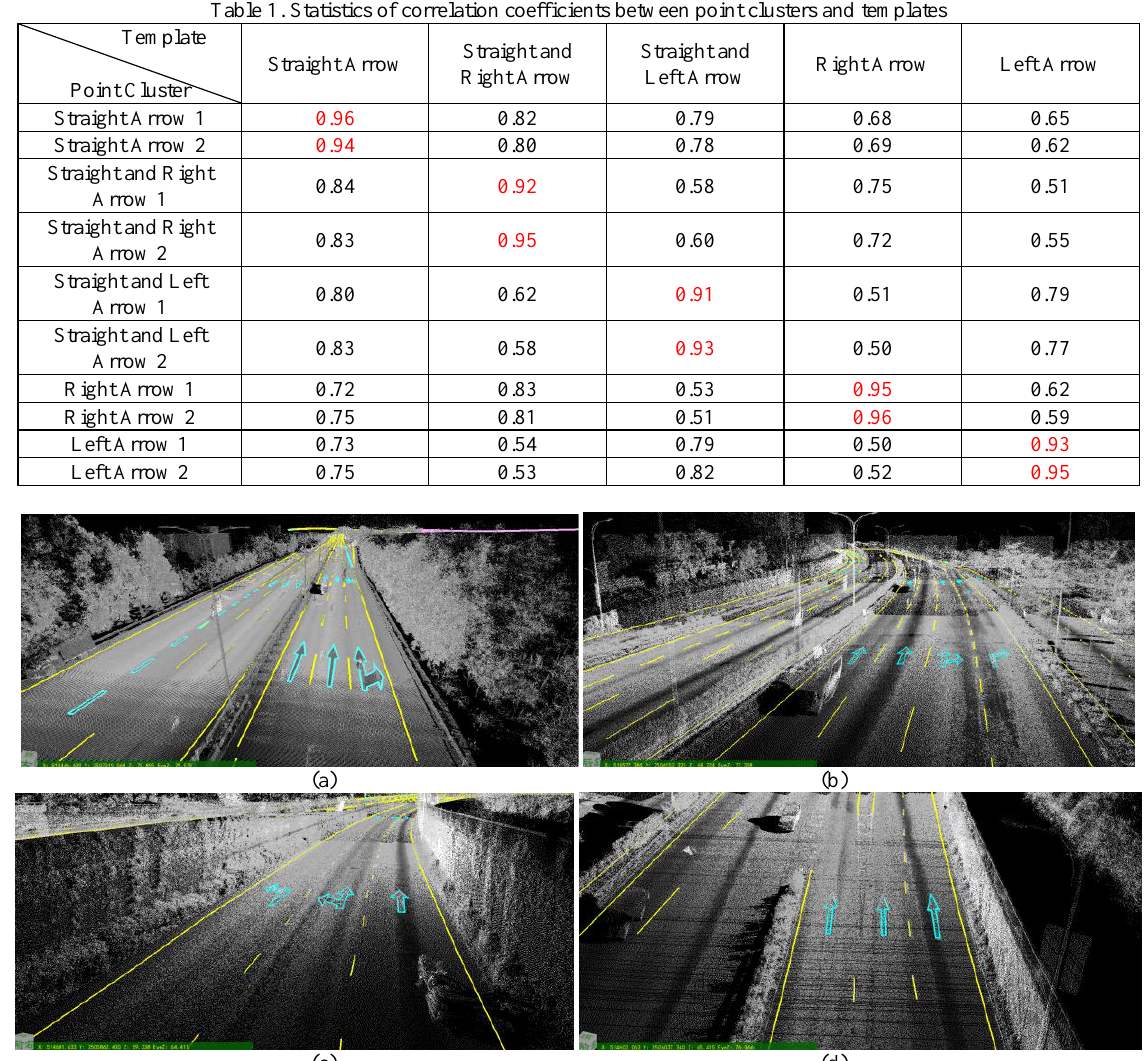
Figure 10. Final vectorization results of road